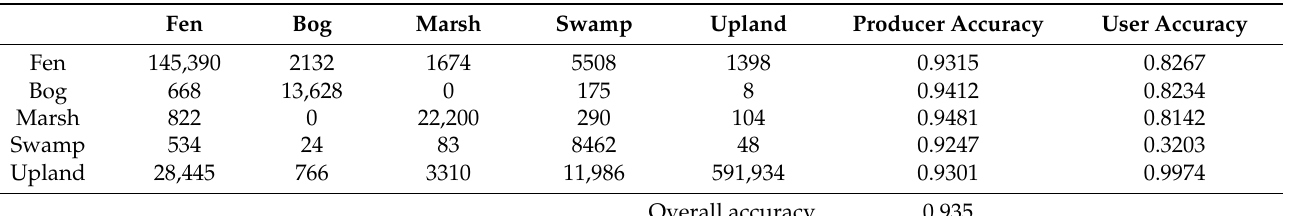
Table 6. Confusion matrix of the proposed ensemble classifier. Rows represent the classification, while columns represent the reference.